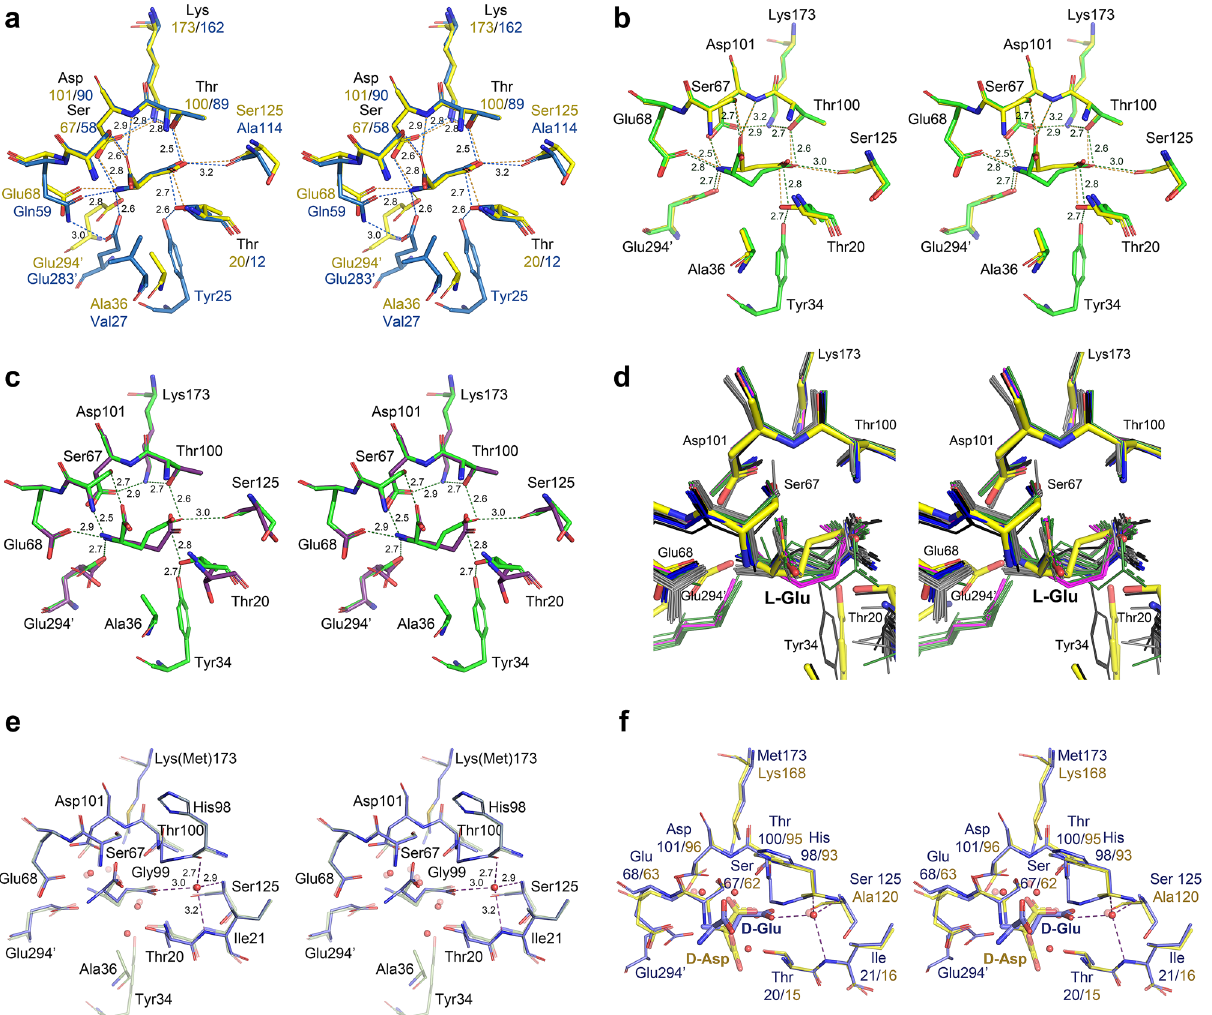
Figure 4. Complexes of PGA with L-Asp and L-Glu. ( a ) Superimposed active sites of PGA (yellow, protomer B in structure 2) and EcAII (blue, protomer A in structure 6pac) in complex with L-Asp. Equivalent residues are labeled. Labels with primed numbers indicate residues contributed by another protomer from the same tight dimer. Important interactions, common to both complexes, are indicated with dashed lines; however, for clarity the corresponding distances are shown for the EcAII:L-Asp complex only. Tyr34 was not visible in the PGA complex. ( b ) Comparison of L-Asp and L-Glu binding to the PGA active site. L-Asp complex (yellow) represents the active site B in structure 2 (Tyr34 not visible). Complex with L-Glu (green) represents the active site C in structure 3. Conserved H-bonds are indicated by dashed lines for both complexes; however, for clarity the distances are shown for the PGA:L-Glu complex only. ( c ) Two binding modes in PGA:L-Glu complexes. Superimposed active sites of PGA are shown for the complexes with L-Glu bound in cat + (green, protomer C in structure 3) and cat- (dark violet, protomer B in structure 3) conformations. Important interactions (primarily H-bonds) between the substrate and active site residues are indicated by dashed lines with corresponding distances. ( d ) Structures of L-asparaginase/L-Glu complexes compared to the complex in PGA. Aligned fragments of all active sites shown as thin sticks are colored green (5k4h), magenta (5k45), black (5hw0), gray (2hln), and blue (1hfw). Active site C from the PGA complex (structure 3) is shown in thick yellow sticks. ( e ) Structural alignment of two non-covalent complexes PGA(K173M):D-Glu (blue) and PGA(wt):L-Glu (semi- transparent gray). ( f ) Superposition of the active sites of PGA(K173M):D-Glu (blue) and ErA(wt):D-Asp (semi- transparent yellow). Figure was prepared with the licensed programs PyMol ver. 2.3.2, (Schrodinger LLC) and Adobe Photoshop CC